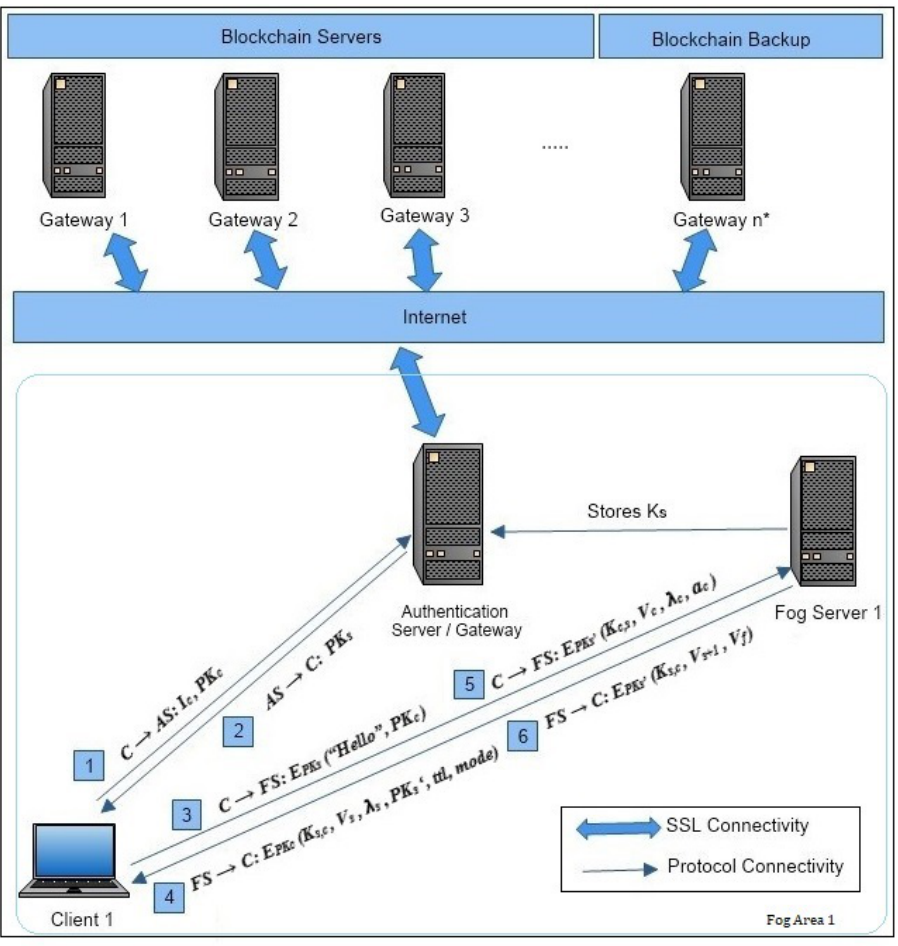
Figure 2. System model for the hash-chain fog/edge